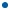
Example of left ventricular three-dimensional co-registration of VT re-entrant activation, electrogram frequency composition, and putative scar substrate.A. VT figure-of-eight re-entrant activation demonstrating earliest pre-systolic activation (EA) occurring at the antero-apical-septum. A1. Lead II surface ECG during VT. A2. Intracardiac unipolar electrogram during VT recorded from site EA. B. Observation of high spectral power density (RMS) in proximity to site EA spanning 220-240Hz of the local unipolar electrograms during sinus rhythm. B1 panels. Epicardial, mid-myocardial and endocardial unipolar electrograms recorded during sinus rhythm from site EA demonstrating delayed fractionated components and their associated d2 scale wavelet decomposition (red). B2 panels. Histogram of spectral frequencies of d2 scale decompositions demonstrating dominant frequencies occurring between 200 and 220Hz at the EA site. C. Corresponding voltage map indicating proximity of EA to the putative scar border zone. D. Corresponding dV/dtmin map demonstrating a high degree of electrical heterogeneity within proximity to EA. ● = plunge needle electrode recording sites.